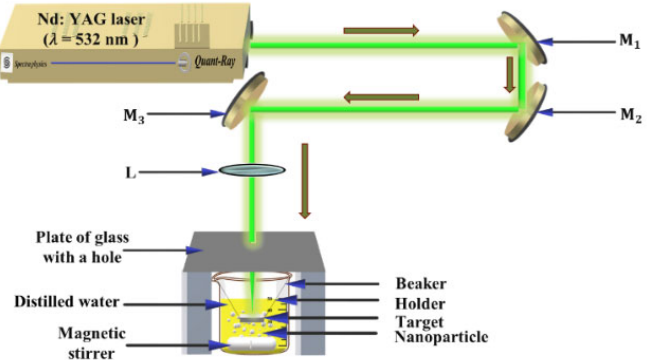
Figure 1. Schematic diagram of laser ablation experimental setup. L, convex lens; M1, M2, and M3, highly reflecting mirrors.